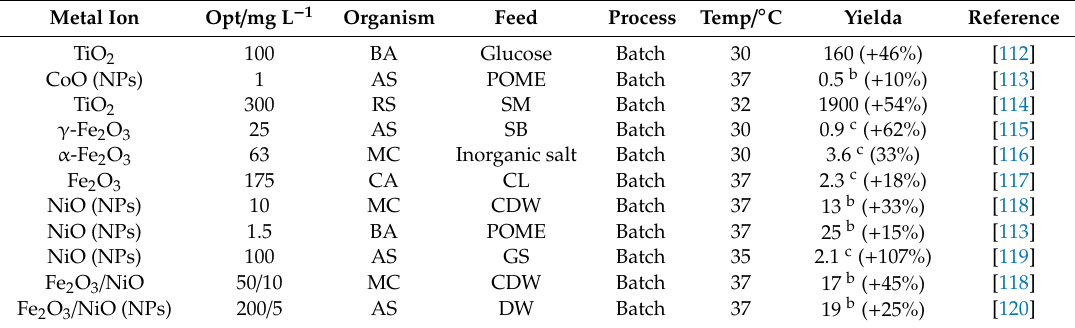
Table 4. Impact of metal oxide upon the activity of nickel-contained hydrogenase for hydrogen